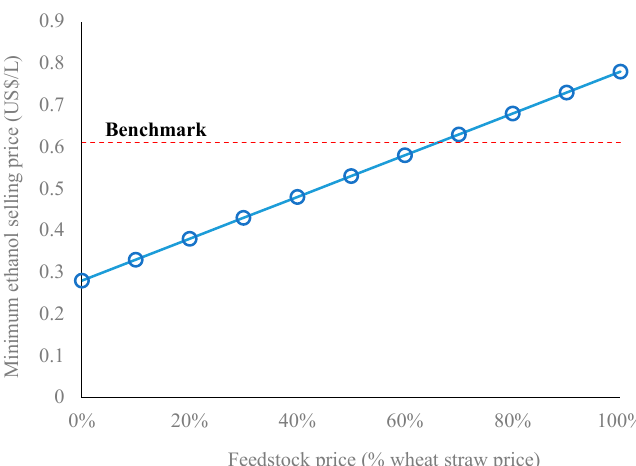
Figure 4. Minimum ethanol selling price as a function of the feedstock price in the animal bedding biorefinery with water recycling.